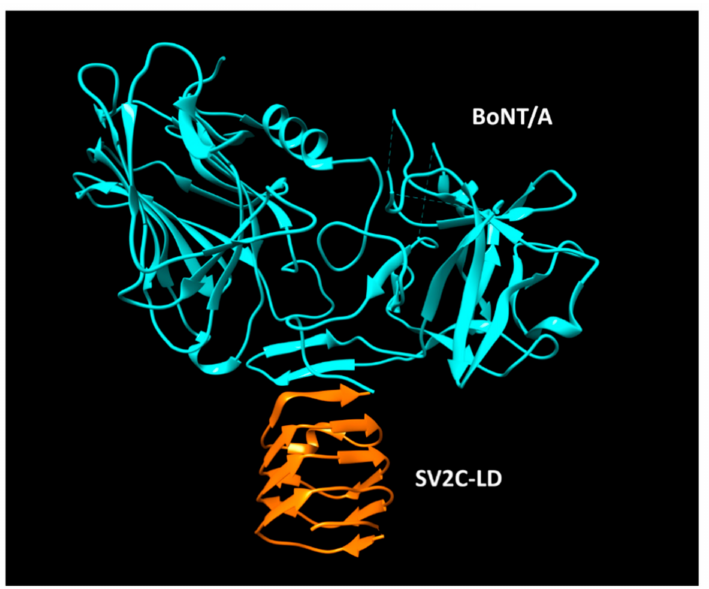
Figure 12. Structure and analysis of SV2C. The top panel is the ribbon diagram of the structure and electronic potential surface analysis. The bottom panel is the interface model calculated by